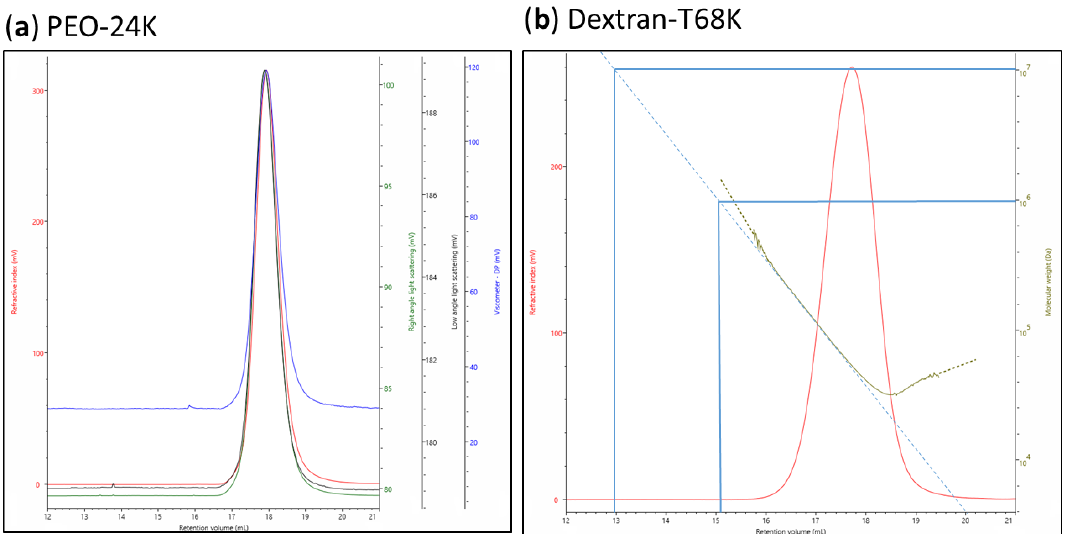
Figure 8. MWD plot measured by high-performance size exclusion chromatography (HPSEC) (OMNISEC) of standards: ( a ) PEO-24K for light scattering / triple detection calibration, ( b ) Dextran-T68K for validation of the calibration, with excellent agreement M w vs. retention time (mL) relation ( M w (Dextran-T68K) Malvern = 68162 ± 450 Da , M w ( Dextran-T68K) Validation = 66807 ± 291 Da).